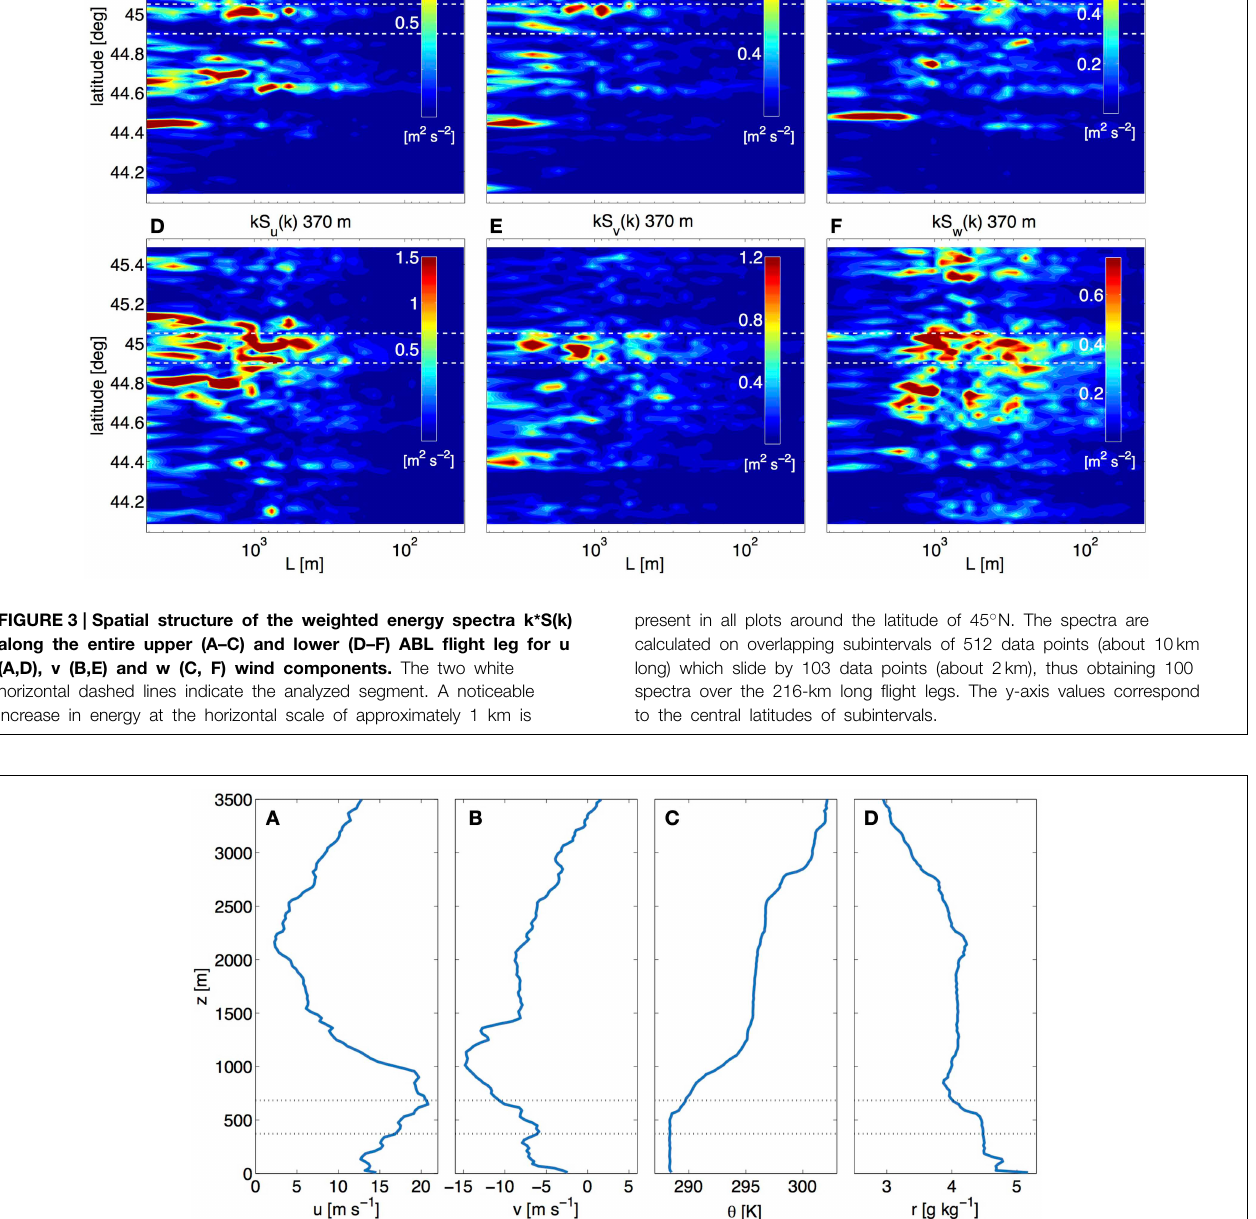
FIGURE 4 | Vertical profiles of the (A) longitudinal u and (B) transverse v wind components, (C) potential temperature θ and (D) mixing ratio r from the dropsonde S3 released at (13.63 ◦ E, 44.96 ◦ N). Horizontal dotted lines denote the heights of the two lower flight legs (370 and 680m).